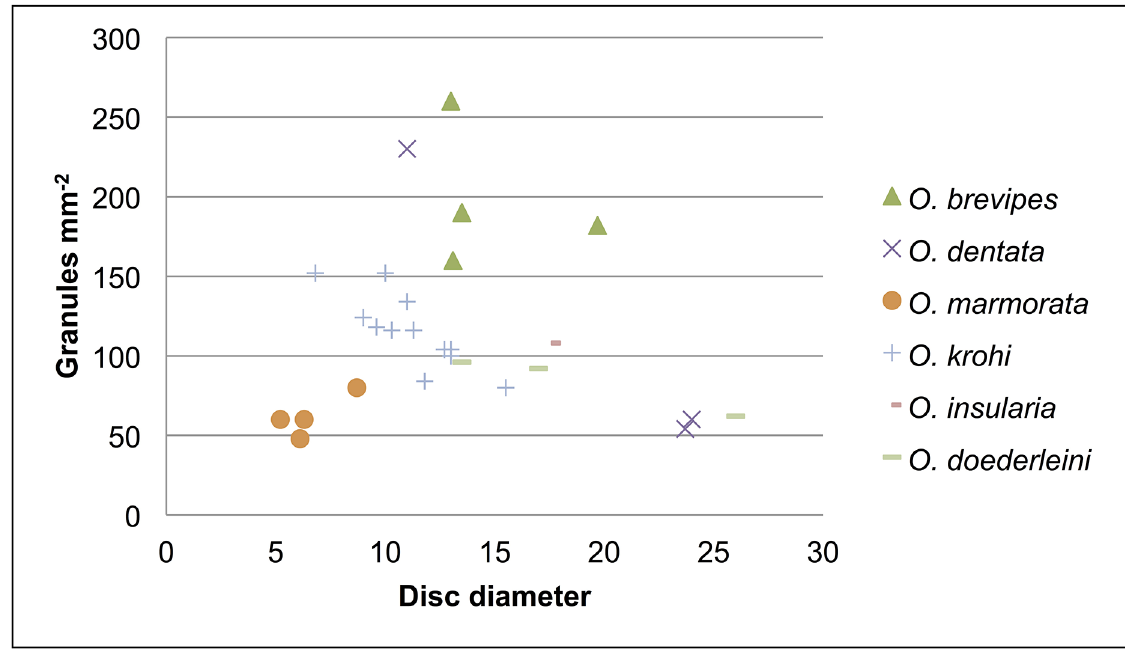
Fig. 7. Granule densities in relation to disc diameter of the examined nominal species of Ophiocoma , from Table